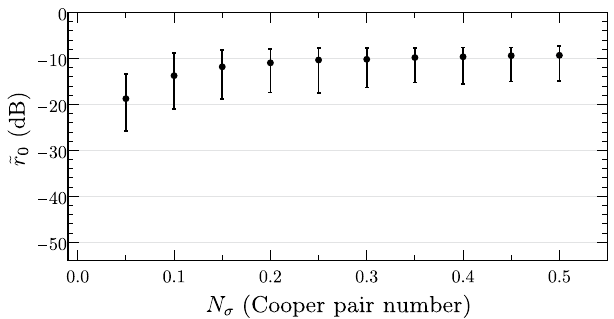
FIG. 6. Uniform charge disorder in the original model. The median of r 0 , ˜ r 0 , is plotted as a function of the standard devia- tion of the charge noise distribution N σ . Error bars indicate the spread from the first quartile to the third quartile of r 0 for each value of N σ . The parameters for ideal tuning are the same as in Fig.